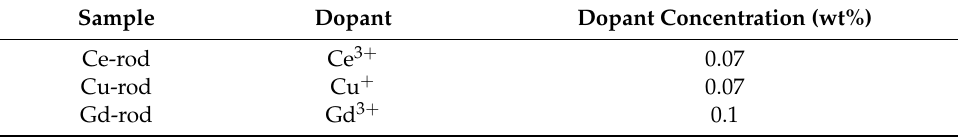
Table 1. Summary of tested